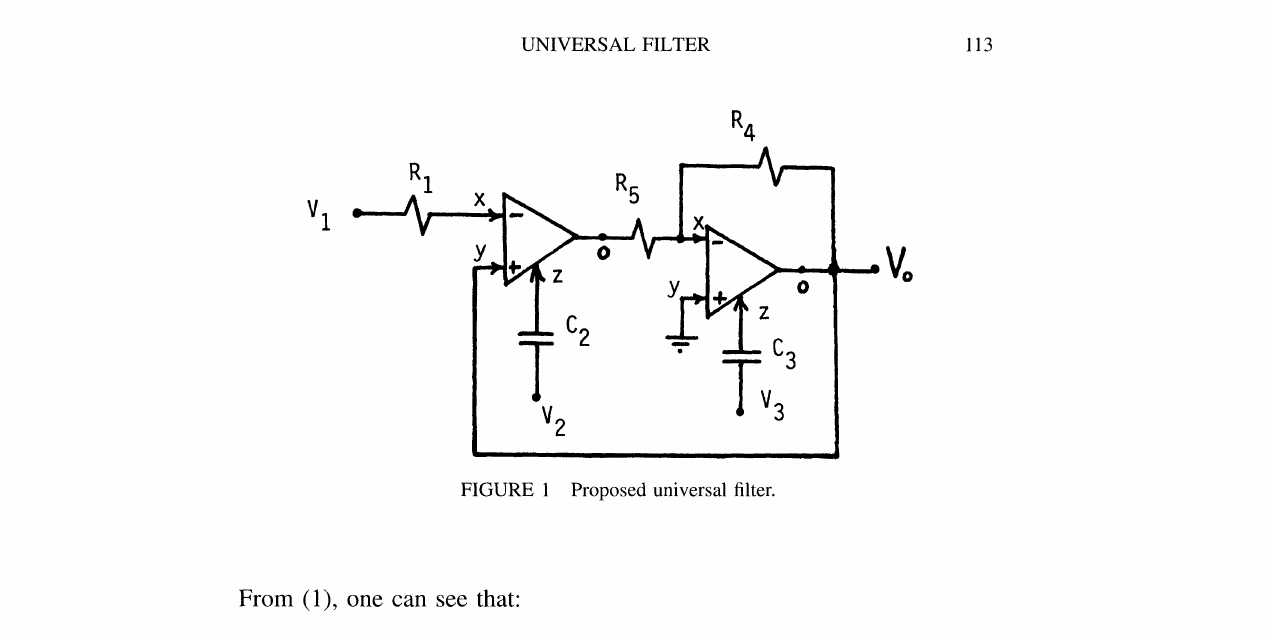
FIGURE Proposed universal